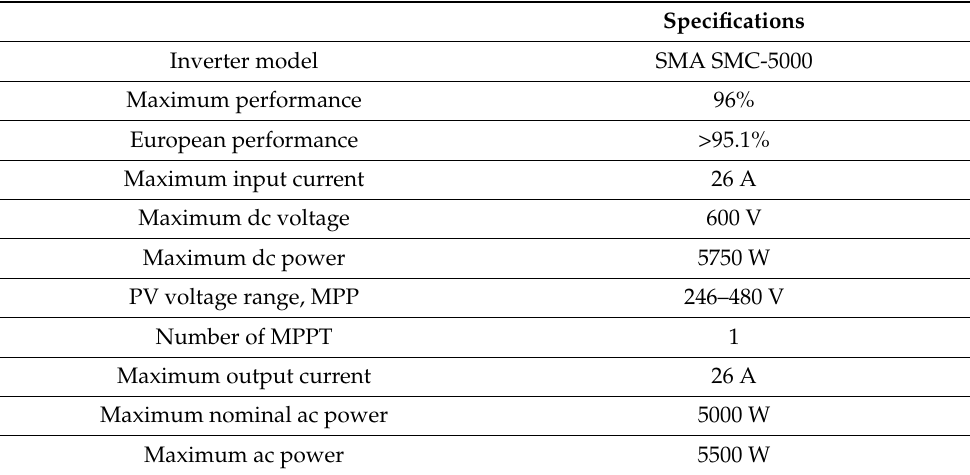
Table 2. Inverter